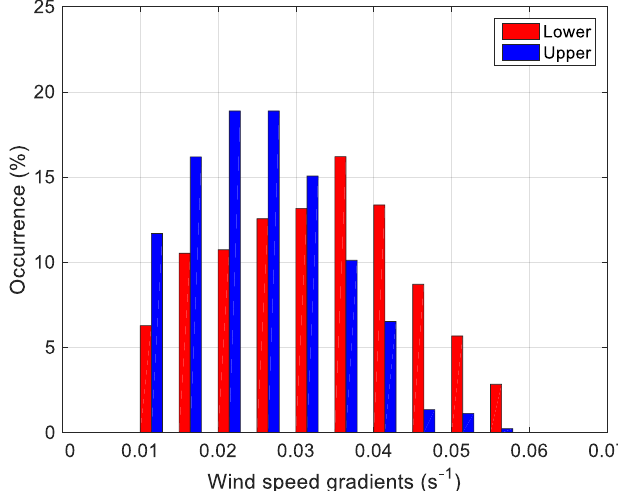
Figure 29. ( a ) Wind speed profiles normalised to V max versus the height normalised to H Vmax and ( b ) profiles of wind direction deviation from the direction in the LLJ core versus the height normalised to H Vmax . Red and green lines indicate the linear fitting functions.